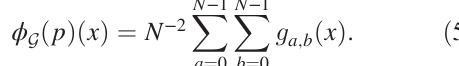
Fig. 6. As expected, the accessible information achieves a maximum of ln 2 at θ ¼ 0 (or θ ¼ (cid:3) π ), which corresponds to a measurement of whether the particle is on the left or right side of the box. The accessible information falls nonlinearly (but continuously) to a minimum of 0 at θ ¼ (cid:3) π = 2 , which corresponds to a measurement of whether the particle is on the top or bottom of the